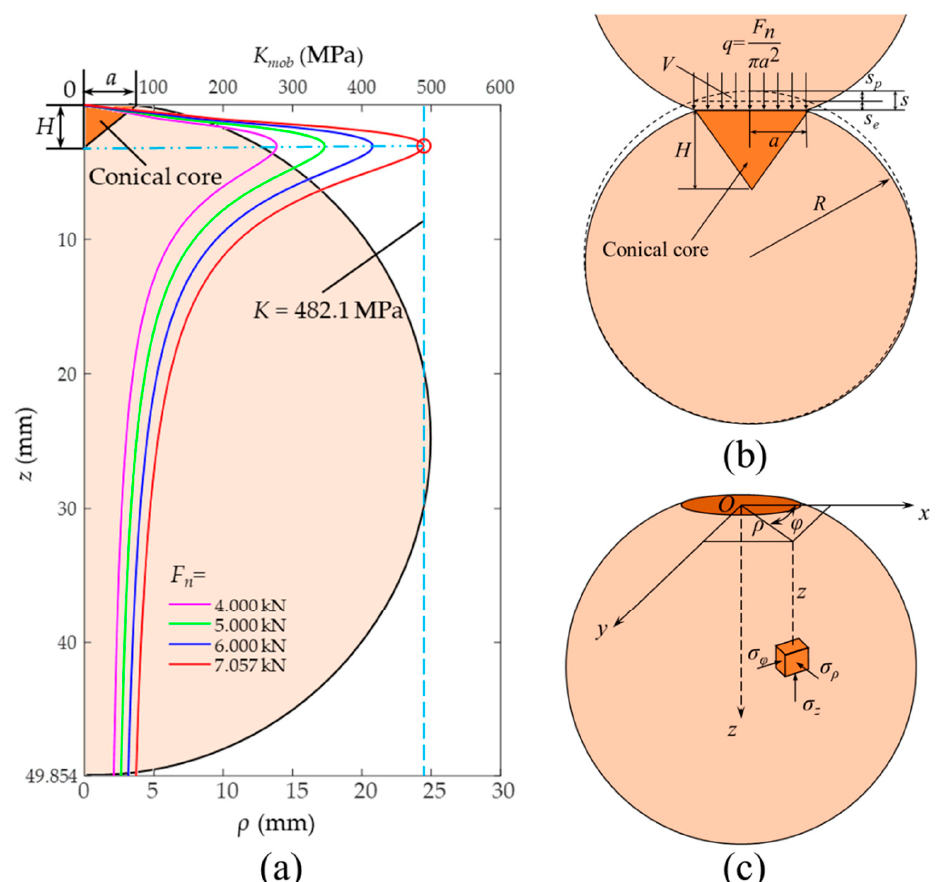
Figure 3. ( a ) A plot of Kmob along the line normal to and through the center of the loaded area for σ c = 50 MPa, σ t = 3 MPa, ν = 0.3, a = 2.7 mm, and R = 25 mm. R is the radius of the sphere. ( b ) A sketch in the elastic deformation stage. ( c ) Cylindrical coordinates ρ ~ φ ~ z and orthogonal normal stresses σ ρ , σ φ , and σ z [34].